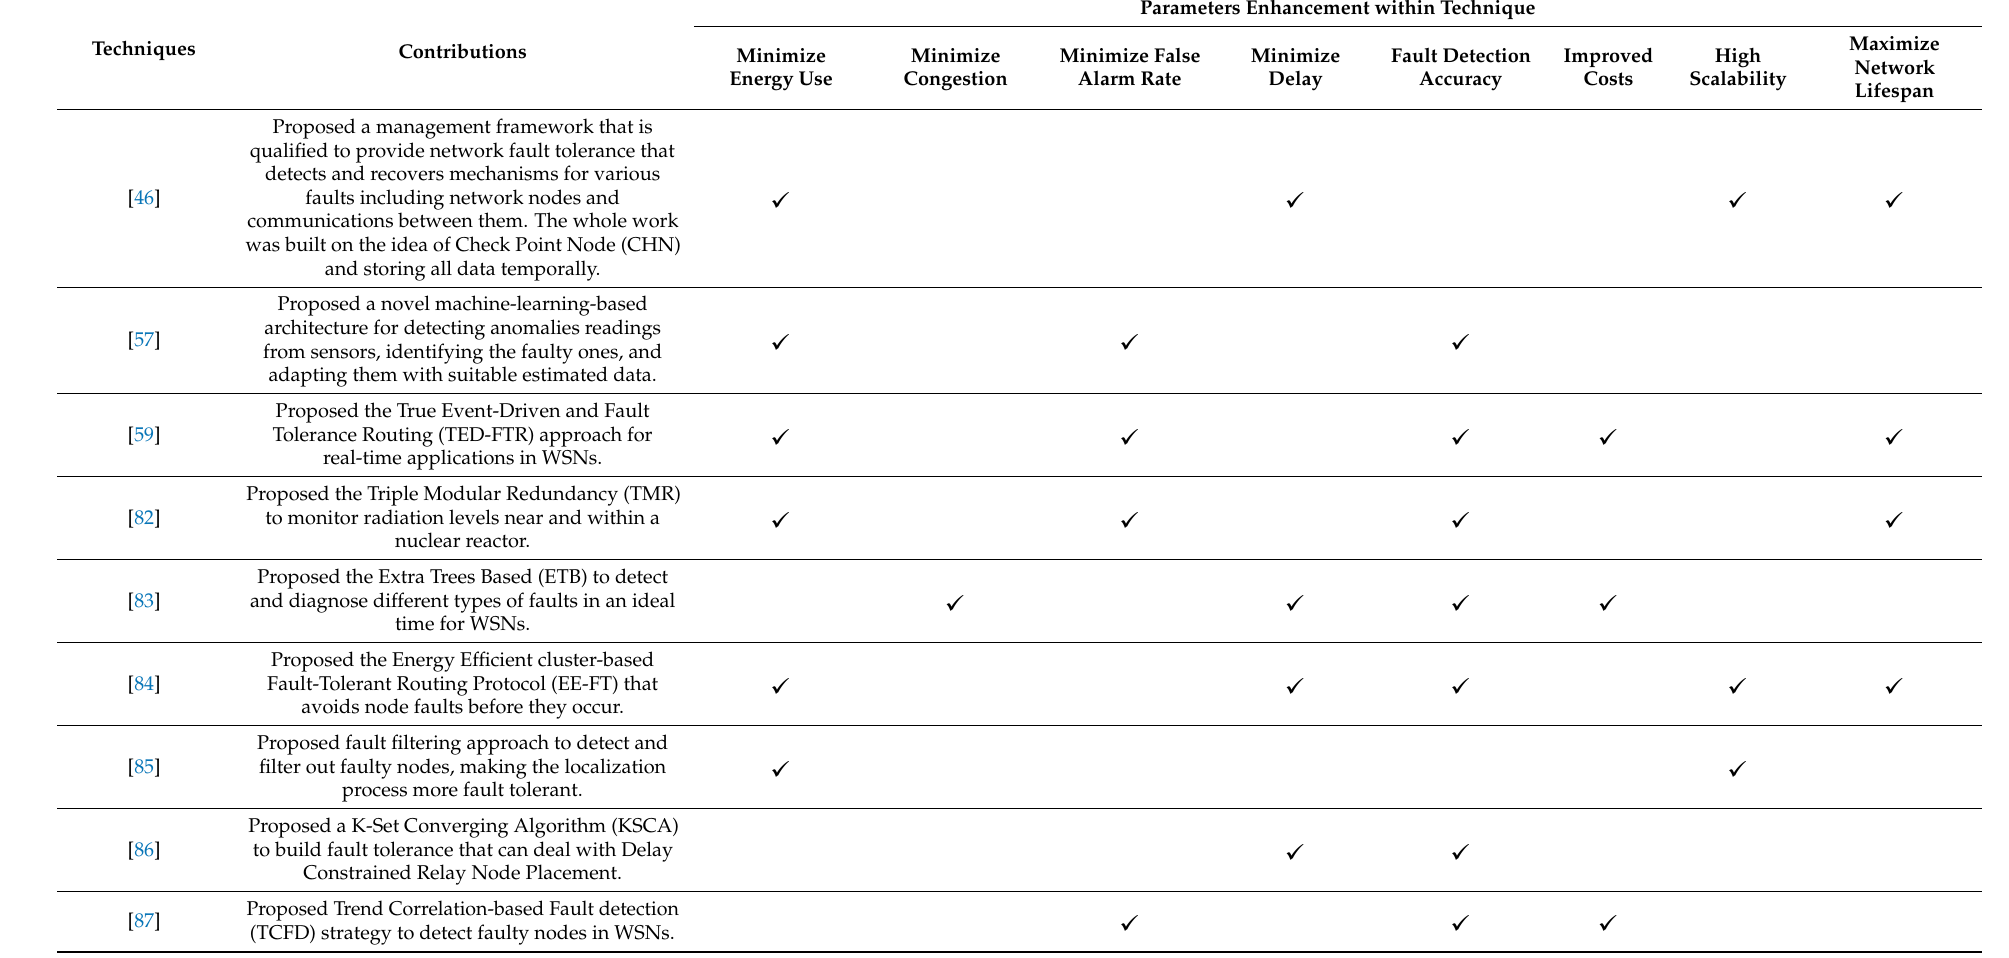
Table A1. Cont. Table 1. Surveys on Fault-Tolerant in WSNs.